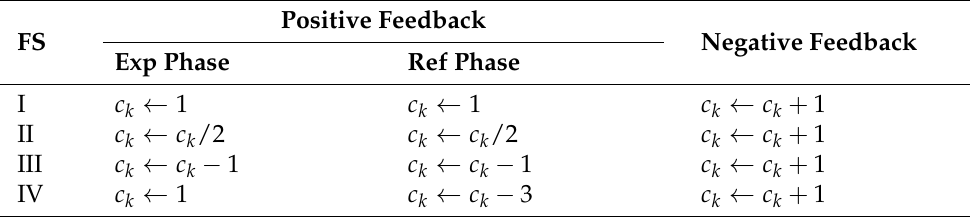
Table 1. Positive feedback strategies. Rules to update the crystallization factor c k . The negative feed- back is the same for all four strategies. FS = feedback strategy. Exp = exploratory. Ref =